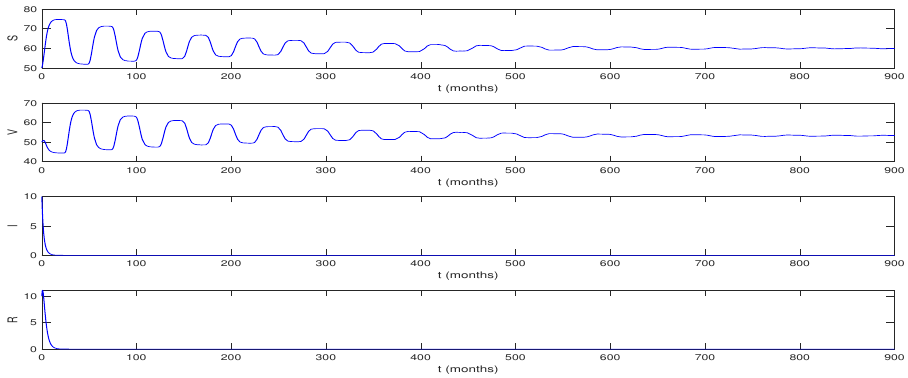
Figure 10. When τ 2 ∗ = 24, τ 1 ∗ = 1, equilibrium E 1 of System (1) is locally asymptotically